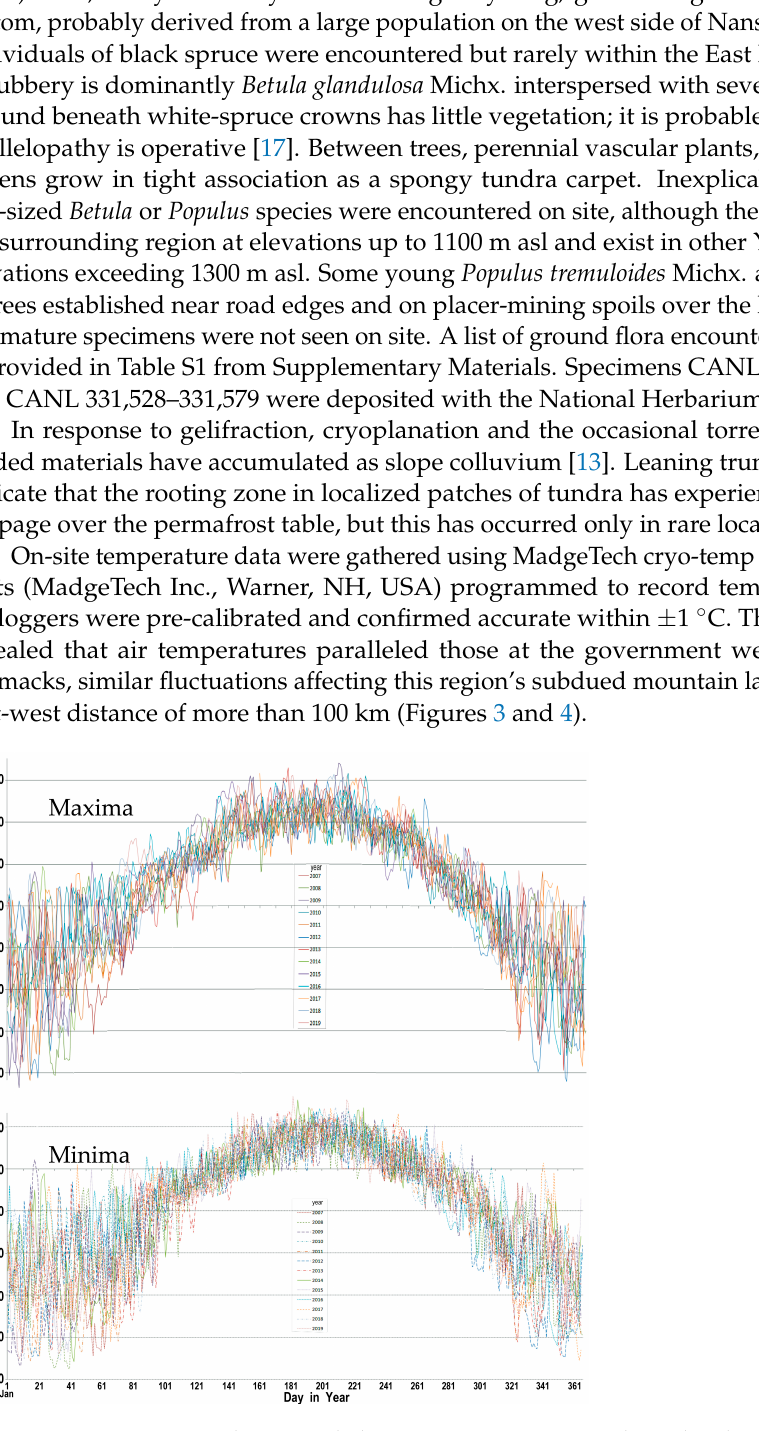
Figure 3. Mean maxima and minima daily temperatures at Carmacks, Yukon based on 2007 to 2019 data gathered by Environment Canada.